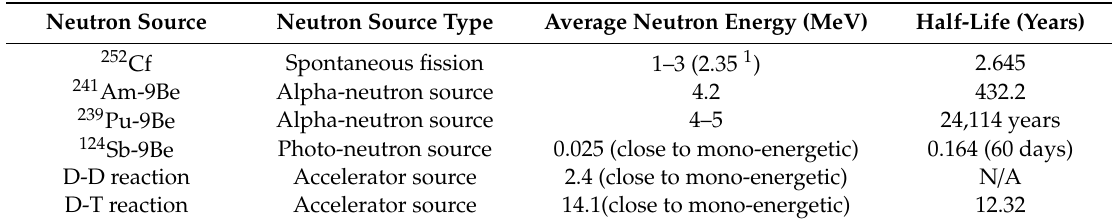
Table 1. Neutron sources and average